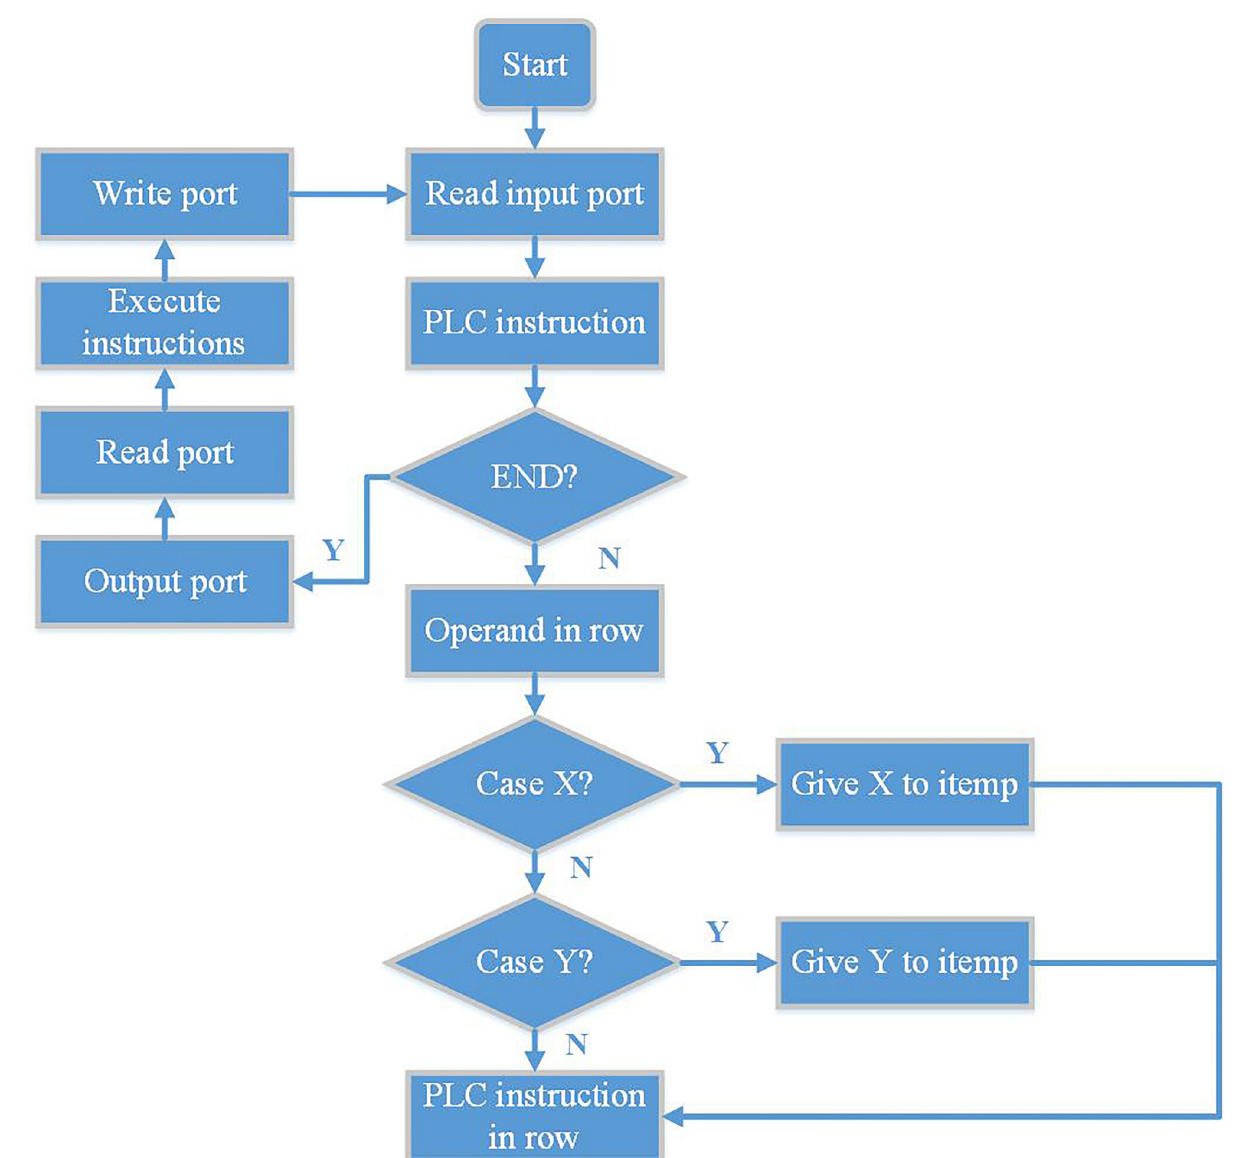
Fig 9. PLC instruction analysis program flow